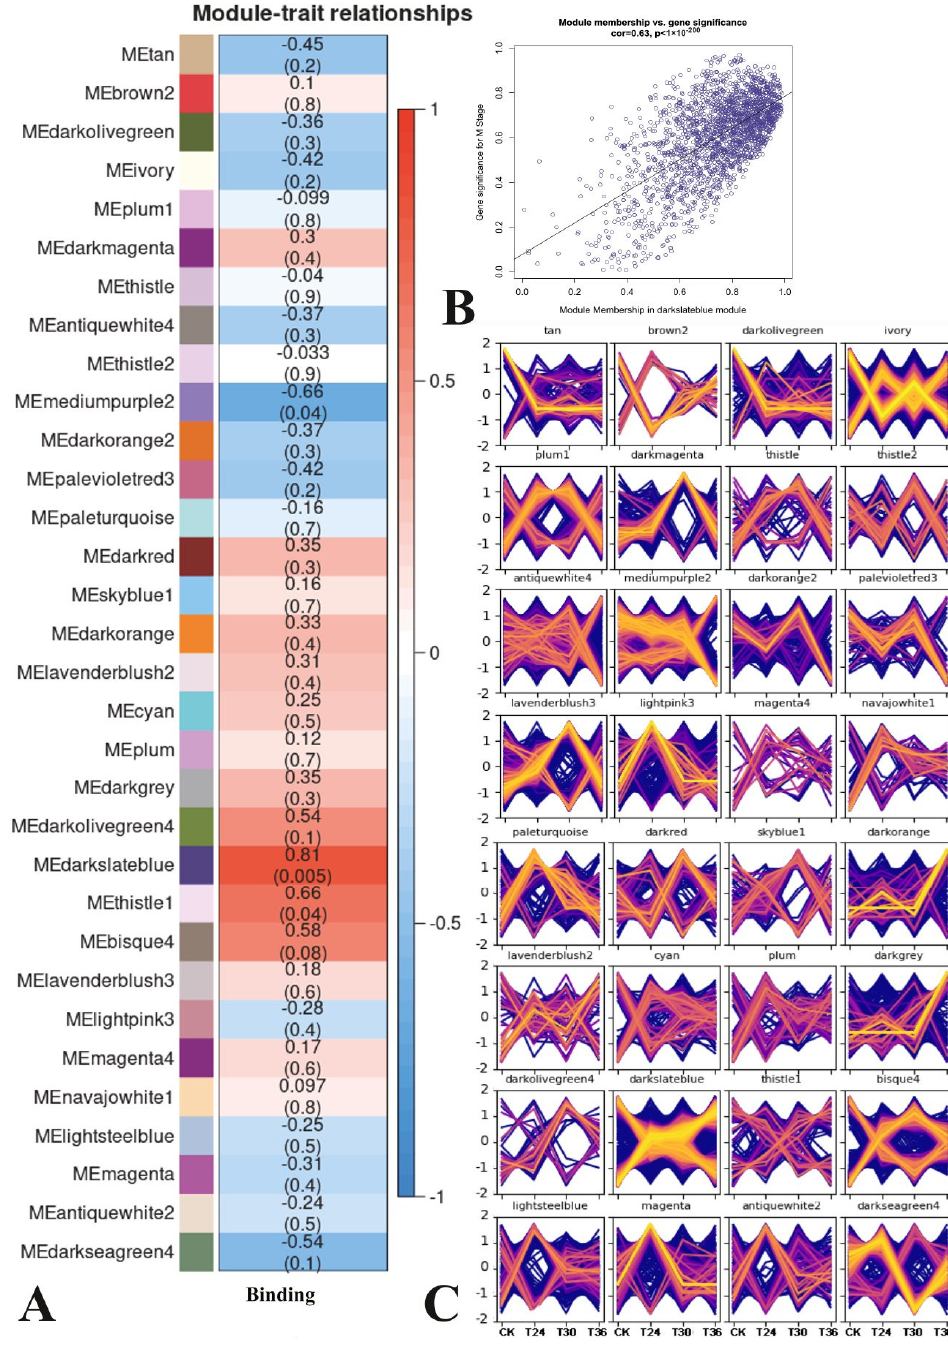
Figure 7. Correlation diagrams of RNA-seq. ( A ) Module trait relation. ( B ) Scatterplot of MM and GS correlations for the most positively correlated module. The dots indicate genes, and the diagonal lines indicate the fitted lines of correlation. ( C ) Genes expression pattern in each module. The yellow lines represent patterns of gene expression that match the pattern most closely, whereas red denotes similar patterns, and blue denotes less similar patterns.